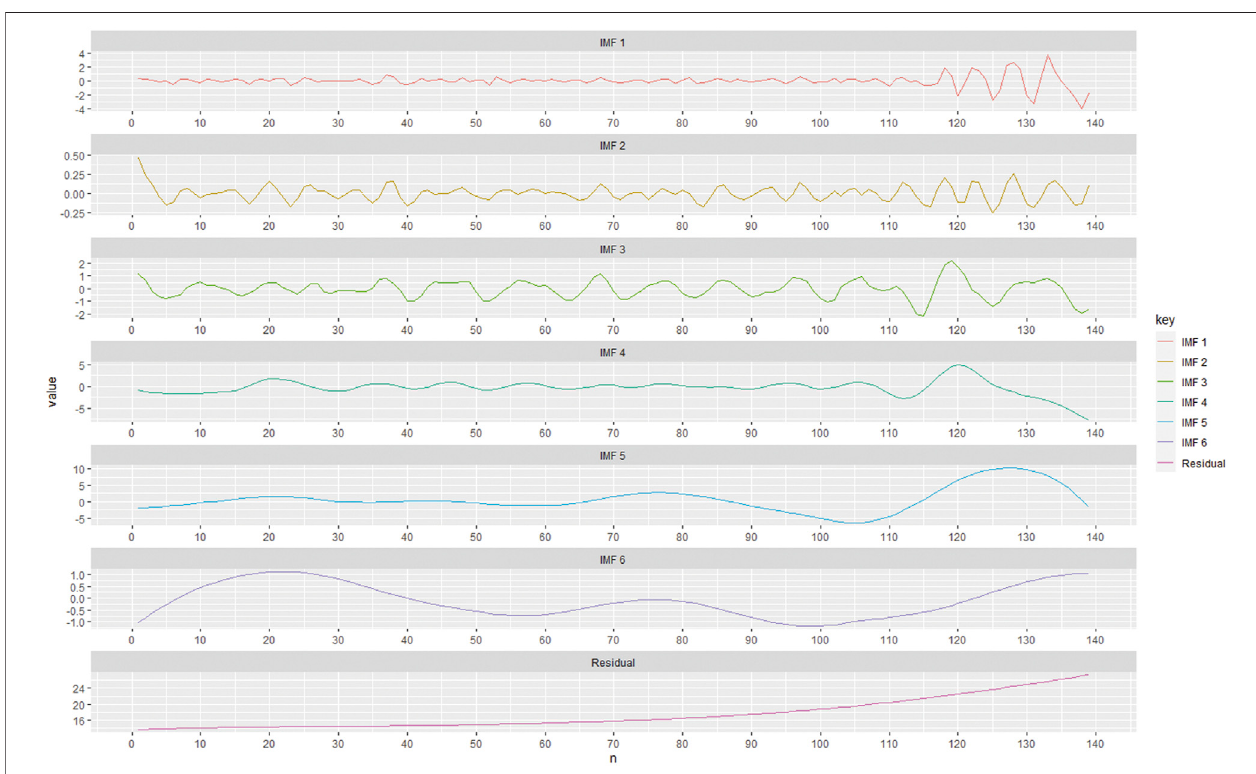
FIGURE 2 | Eigenmode function and trend component of hog price in our country.